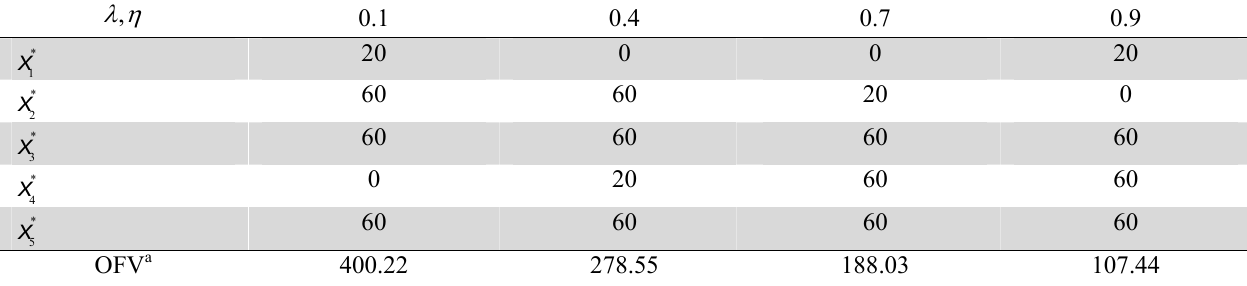
Numerical results (necessity-based model)